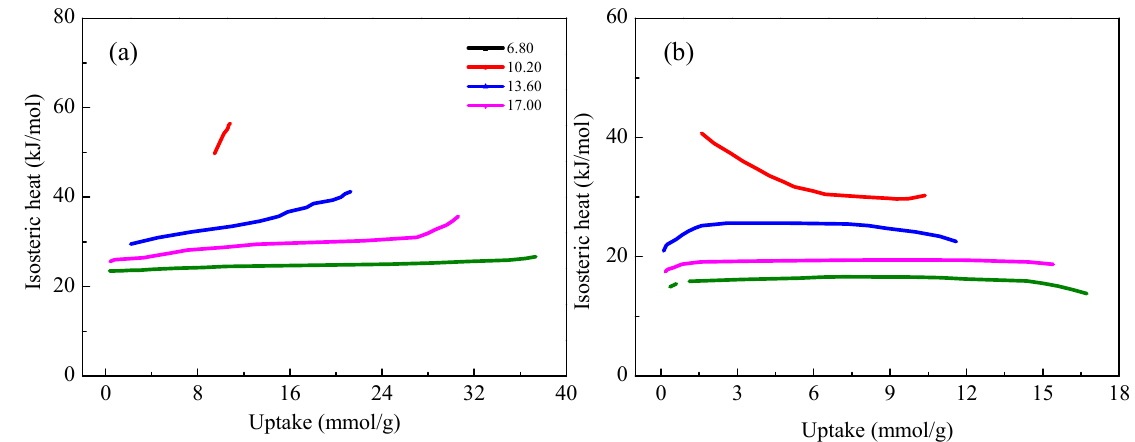
Figure 6. The isosteric heat of CO 2 ( a ) and N 2 ( b ) in the N-MGNs. Gas distribution. To explore the gas distribution in equilibrium states for the pore of N-MGNs, the relative concentration profiles were presented as a function of the distance between layers. The relative concentration is defined as a ratio, that is calculated by dividing actual concentration by average concentration of the gas in the pore. The distribution of both CO 2 and N 2 in each layer of the N-MGNs can be reflected by relative concentration profiles. In most cases, it shows strong primary peaks close, minor secondary peaks, and bulk region [49]. T14he primary peak is resulted from the interaction between the first-layer of gas molecules adsorbed on the pore walls, that is, adsorbed phase. The secondary peak is mainly due to the equilibrating interactions between gas–gas or gas–surfaces, that is, equilibrated phase.